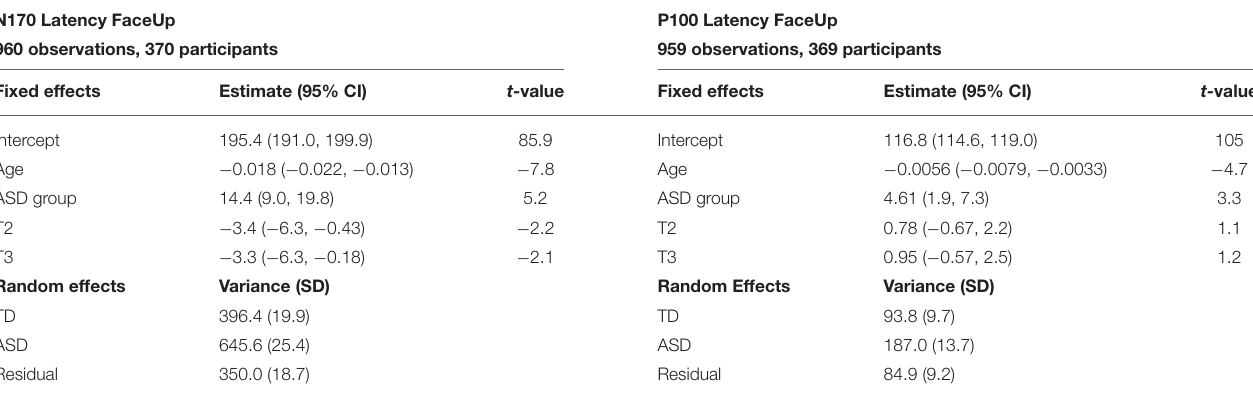
TABLE 3 | Random and fixed effects for N170 latency and P100 latency to upright